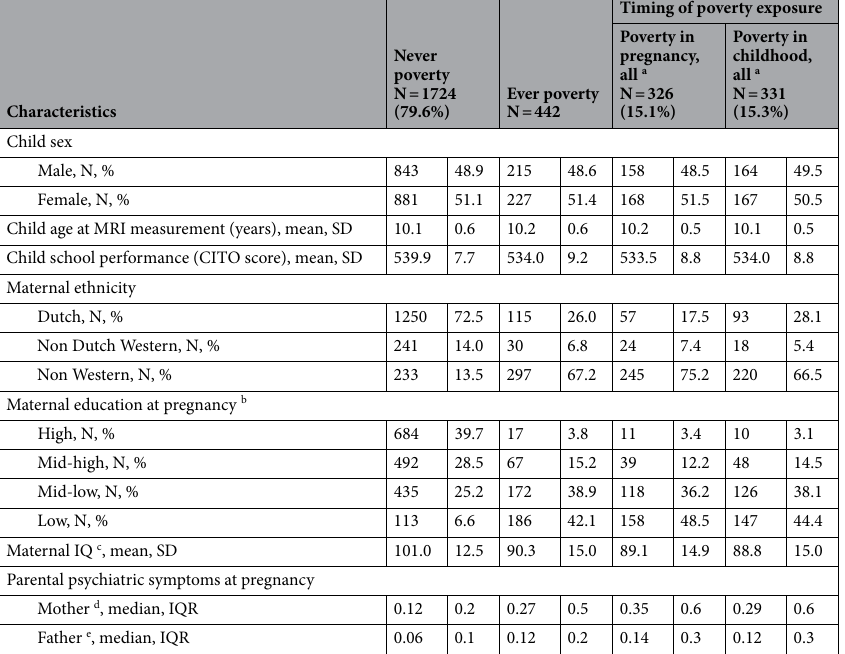
Table 1. Sample characteristics (N = 2166). The data was combined across imputed datasets. Non-Dutch- Western includes Indonesian, American, Asian, European, Oceanian. Non-Western includes Cape Verdean, Moroccan, Dutch Antillean, Surinamese, Turkish, African, American non-Western, Asian non-Western. Ever poverty is a total of "poverty in pregnancy only", "poverty in childhood only" and "chronic poverty". Abbreviations: MRI magnetic resonance imaging, SD standard deviation, CITO Centraal Instituut voor Test Ontwikkeling, IQR interquartile range. a These populations are not mutually exclusive. To see the mutually exclusive sample categorization, refer to Supplementary Table 1. b Missing data N = 54 (2.5%). c Missing data N = 138 (6.4%). d Missing data N = 233 (10.8%). e Missing data N = 583 (26.9%).